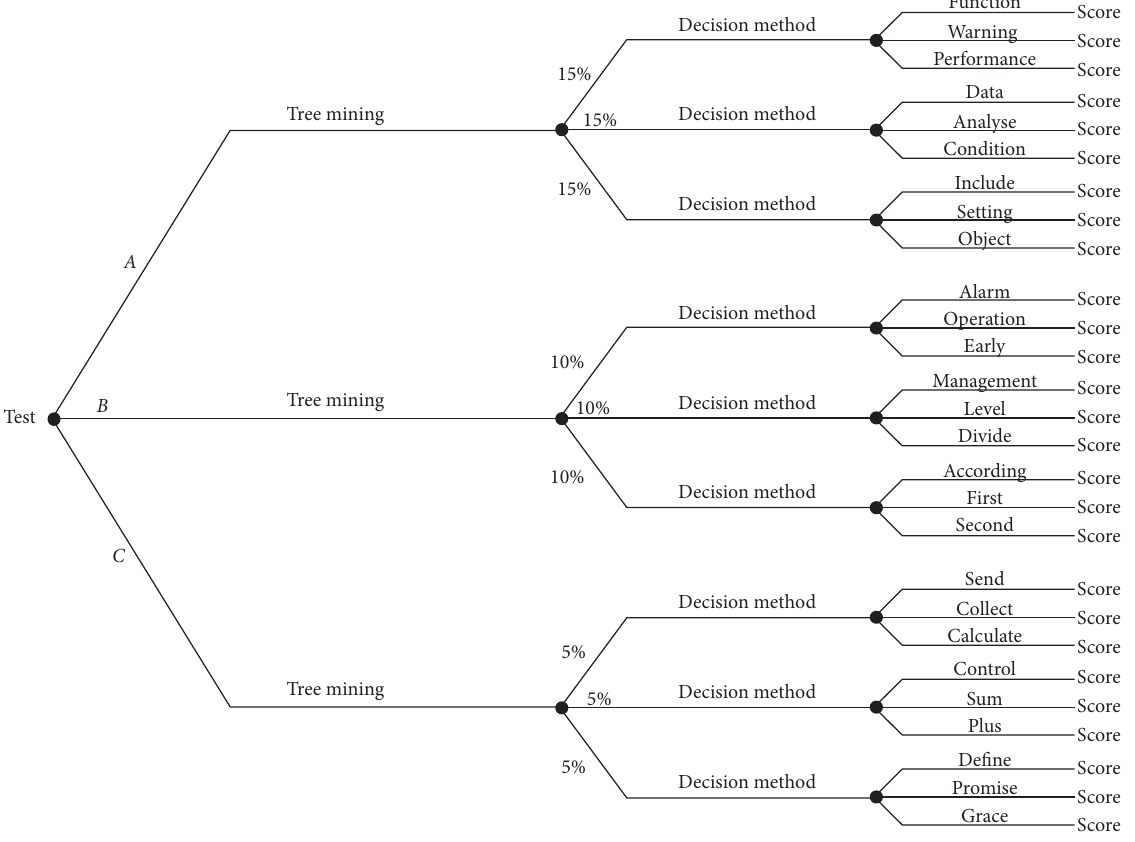
Figure 4: The achievement evaluation